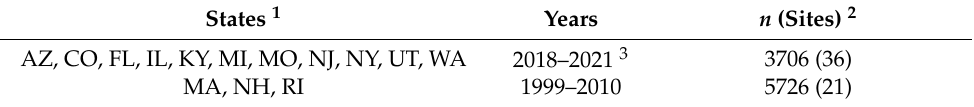
Table 3. Summary of publicly available datasets concerning measurement of background ambient air EO concentrations associated with various current and historical monitoring programs in the